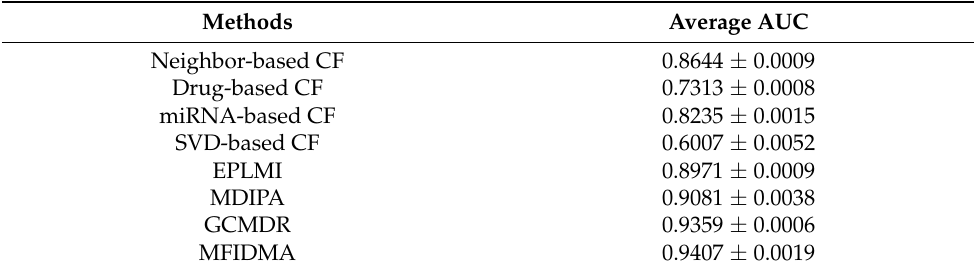
Table 6. Comparison of the prediction performance based on ncDR